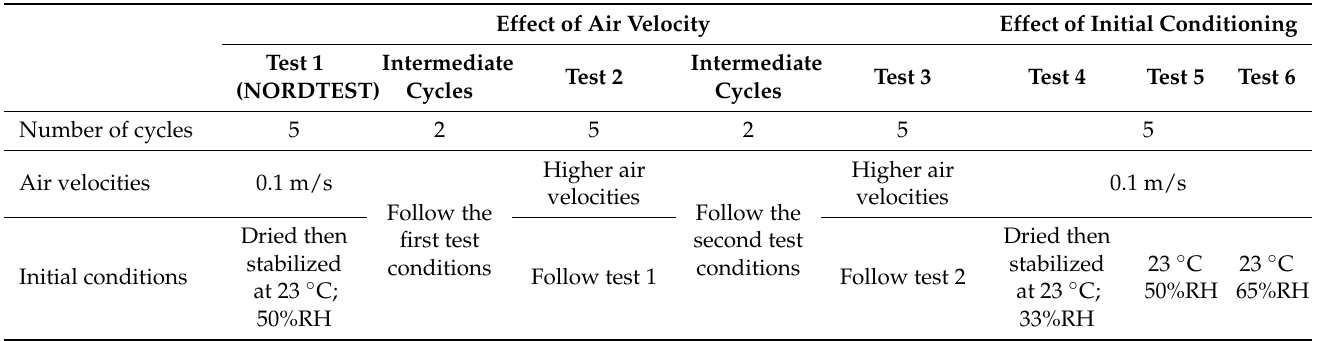
Table 2. Progress of the experimental study.